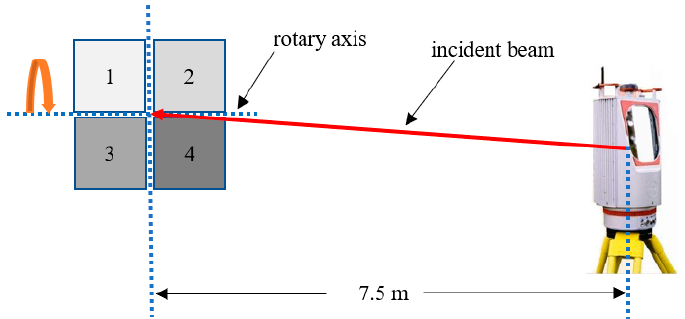
Figure 2. Diagram for the setup of the laboratory experiments.